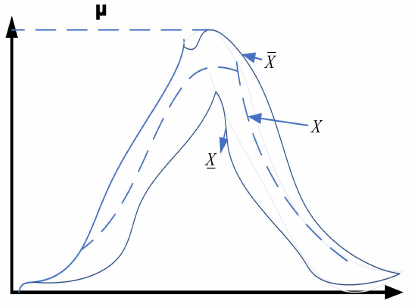
Figure 6. Type 2